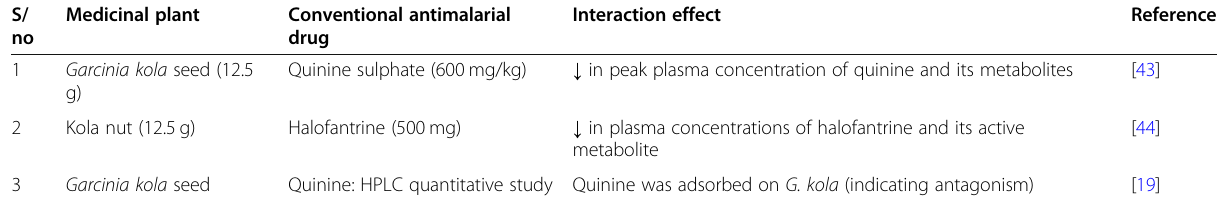
Table 4 Summary of studies on herbal-antimalarial drugs interactions in human volunteers and in-vitro studies S/ Medicinal no